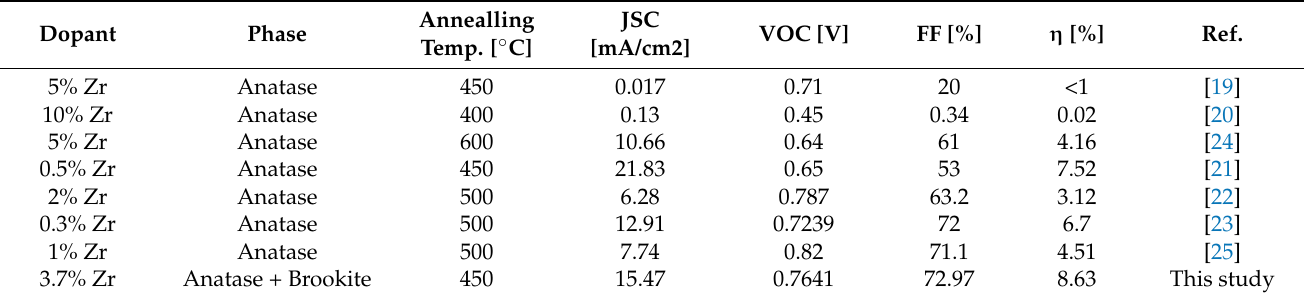
Table 1. List of photovoltaic parameters of DSSCs based on a photoanode prepared using titanium oxide doped with Zr 4+